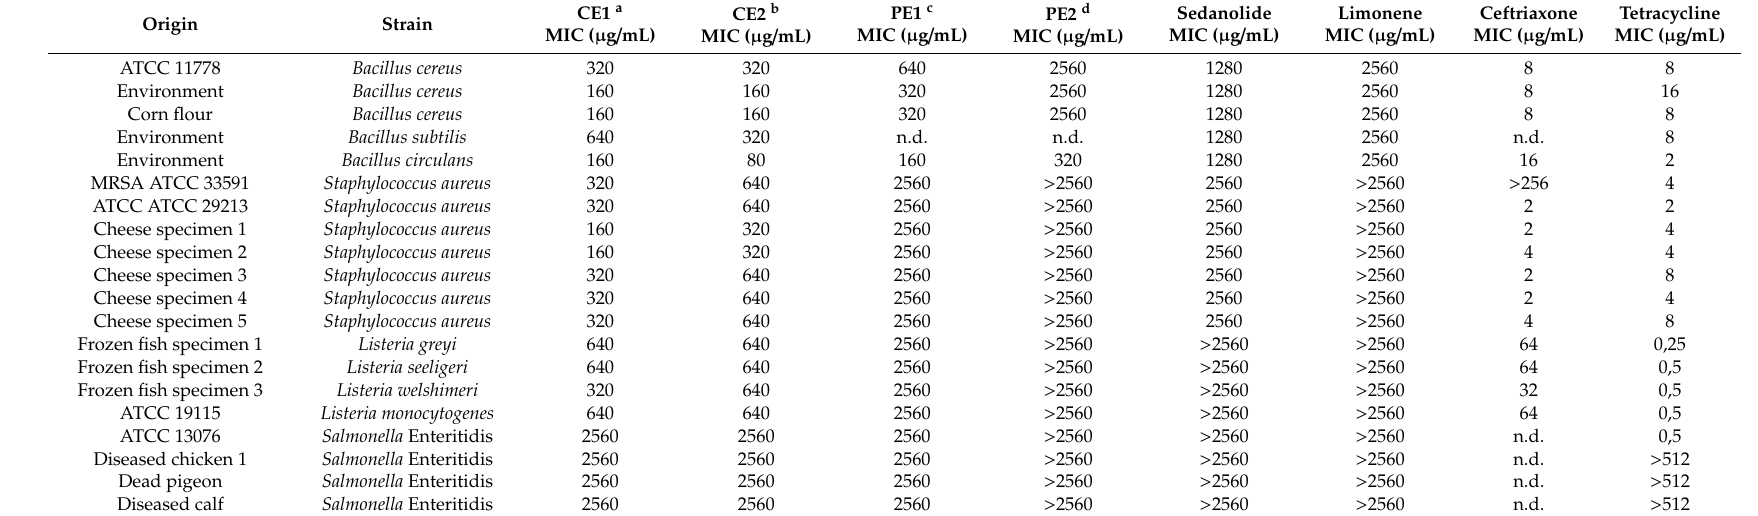
Table 4. Values of the minimal inhibitory concentrations of celery and parsley seed oils obtained by supercritical